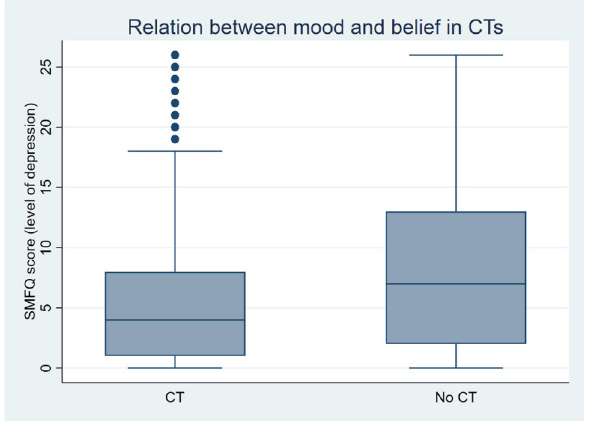
Figure 1. Boxplot of the mood (i.e., SMFQ index) for two categories of individuals: those who believe in a conspiracy theory about COVID-19 (CT) and those who don’t (No